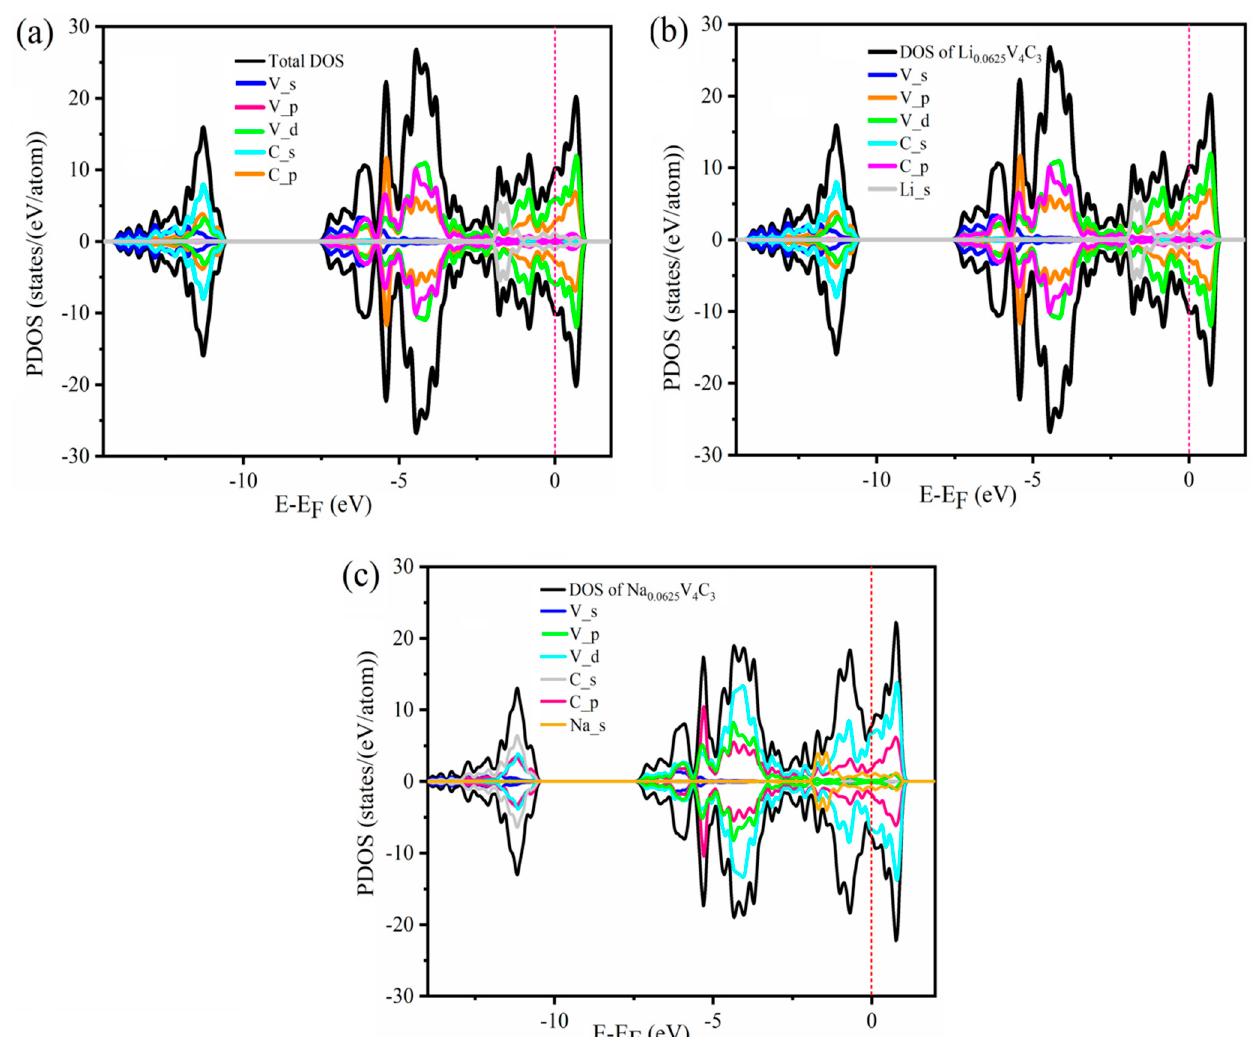
Figure 6. Density of states of ( a ) bare V 4 C 3 , ( b ) Li 0.0625 V 4 C 3 , and ( c ) Na 0.0625 V 4 C 3.